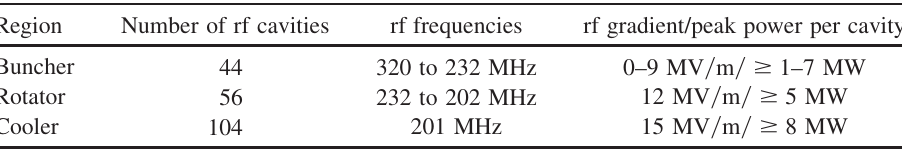
TABLE III. Approximate rf requirements of a magnetically insulated front-end channel.